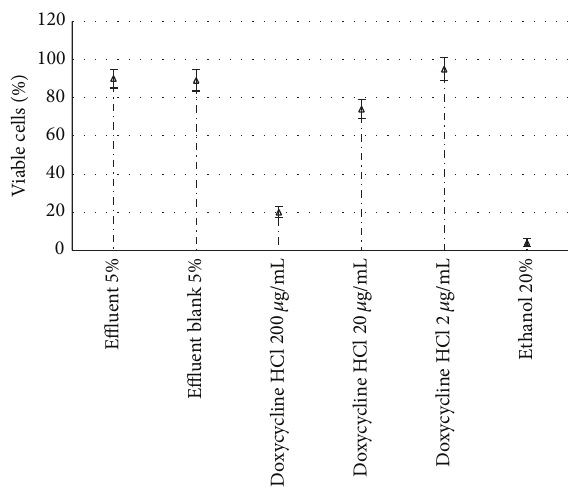
Figure 2: Results of cytotoxicity tests performed by adding the 10- fold concentrated effluent from the Fenton process or doxycycline HCl to the culture medium after 24 h of incubation with L929 cells. Effluent blank did not contain the antibiotic. Ethanol 20% is considered to be responsible for 100% of cell